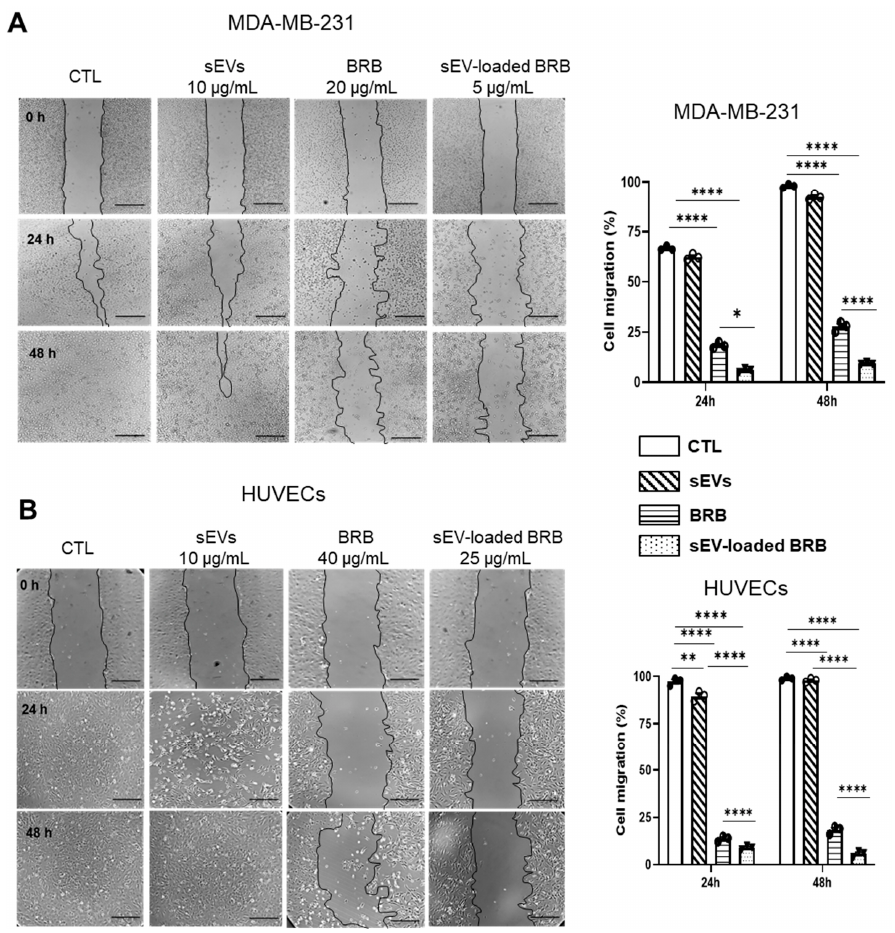
Figure 3. Wound healing assay of MDA-MB-231 ( A ) and HUVECs ( B ) after sEVs, BRB, and sEV- loaded BRB treatment. Cell migration was measured at T = 0 h, T = 24 h, and T = 48 h and analyzed as described in Methods. Horizontal bar = 200 µm. Data are expressed as mean ± SEM of 3–4 independent experiments. * p < 0.05, ** p < 0.01, **** p < 0.0001.